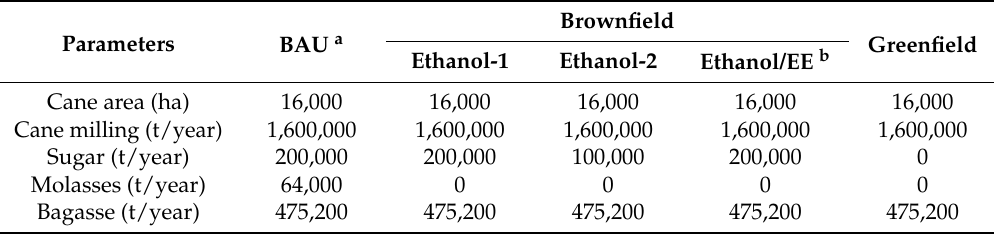
Table 2. Technical coefficients used in the simulation of the business as usual (BAU) and alternative scenarios (i.e., brownfield and